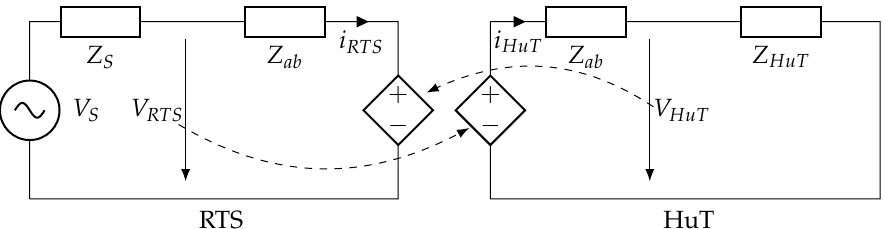
Figure 4. PCD interfacing algorithm for PHiL simulation.